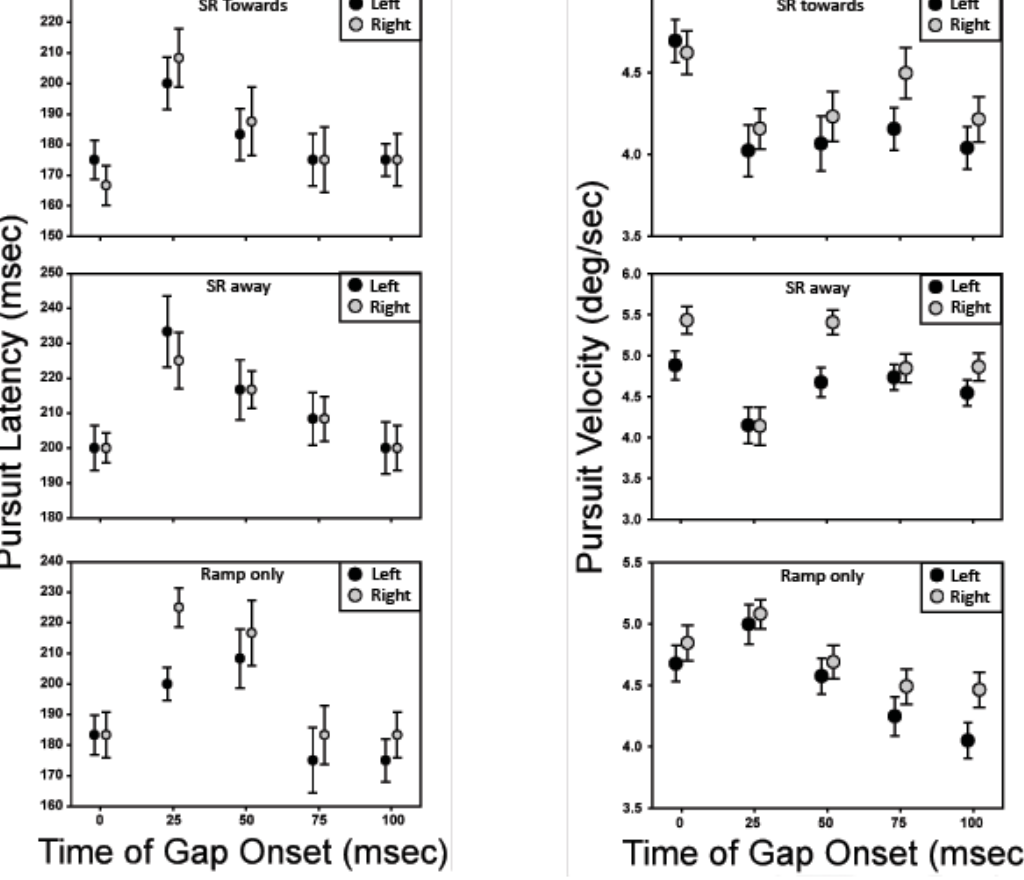
Figure 7 and Figure 8 : Pursuit latency (left panel) and pursuit velocity (right panel) are plotted against the temporal location of the gap. The most disruptive gap onset is 25-50 ms after initiation of target motion. Figure 8 illustrates how the onset of the gap affects the initial pursuit velocity. Again, each panel shows the av- eraged data for a given motion trajectory, with the initial motion direction indicated by the shading of the symbol (black – left; gray – right). For the ‘ramp-only’ condi- tions, the pursuit velocity is slightly elevated when the gap occurs at 25 ms and slowly declines for later gaps. The initial pursuit velocity in the ‘step-ramp-towards’ condition is reduced for all temporal gaps when com- pared to the no-gap condition. In the ‘step-ramp-away’ condition, only the gap at 25 ms causes a reduction in the pursuit